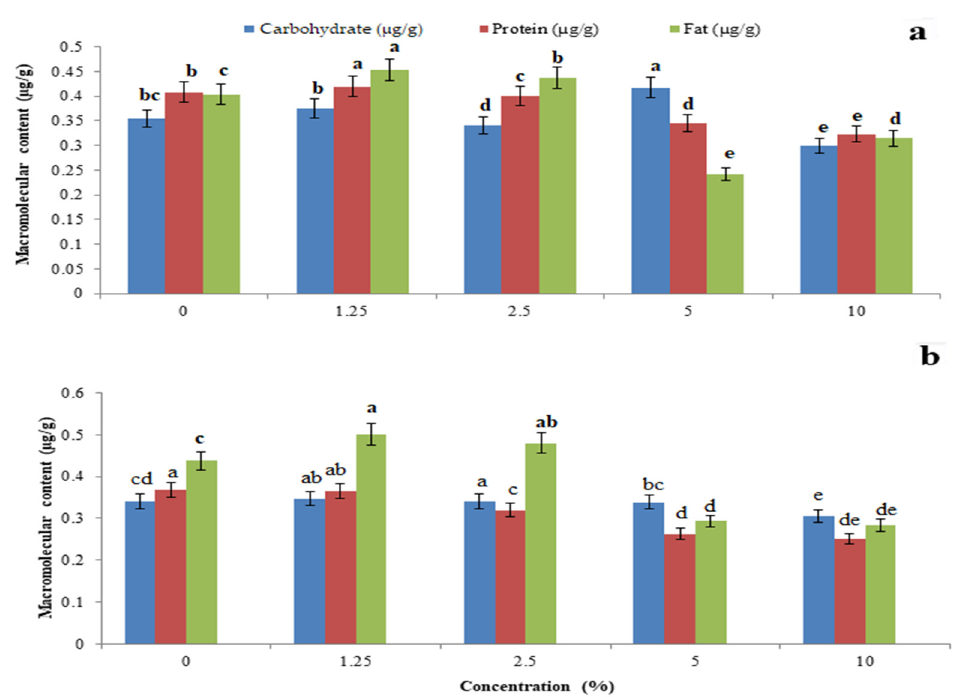
Figure 5. Whole-body carbohydrate, protein, and fat ( µ g/g) of P. solenopsis exposed to different concentrations of P. galabura plant extract ( a ) and P. galabura- AgNPs ( b ). Different letters (among the same concentration for each enzyme separately) above bars indicate significantly different means according to Tukey’s test ( p < 0.05). Bars indicate the standard error (SE).